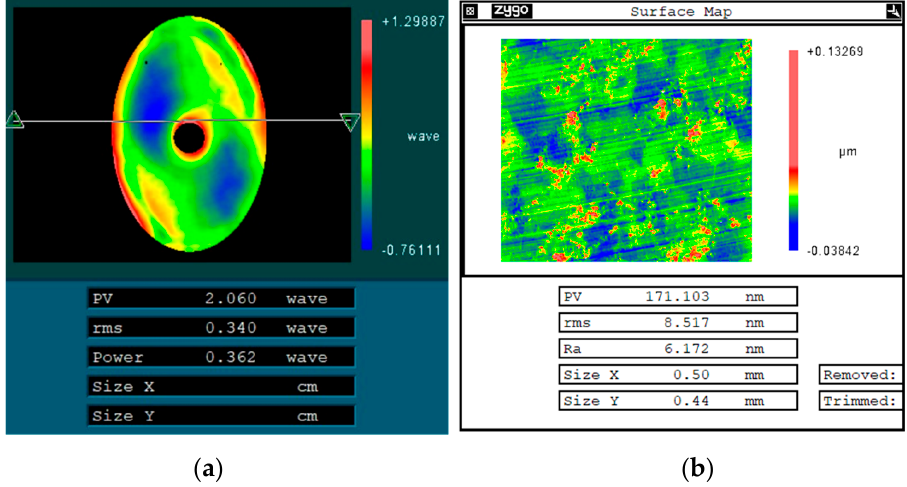
Figure 13. Test results of mirror surface quality: ( a ) low − frequency error; ( b ) high − frequency error.